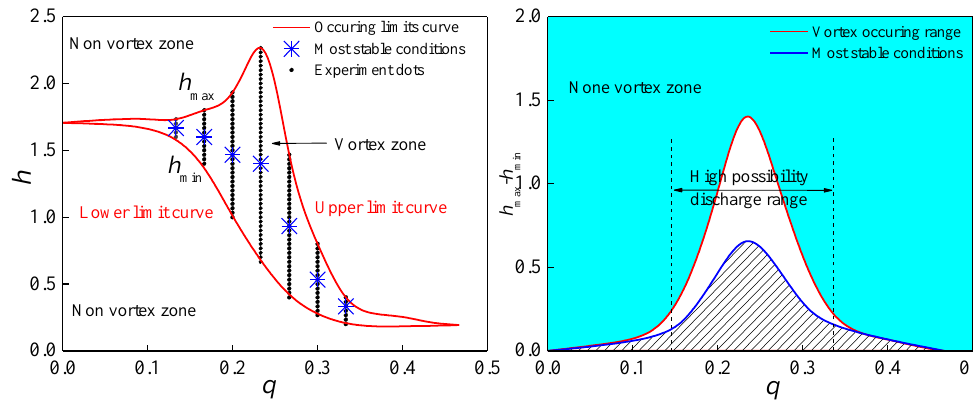
Figure 13. Avoiding rules of horizontal vortex in stepped dissipation wells.